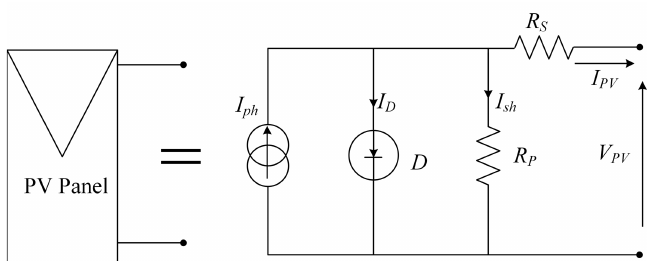
Figure 1. Single-diode model of PV cell